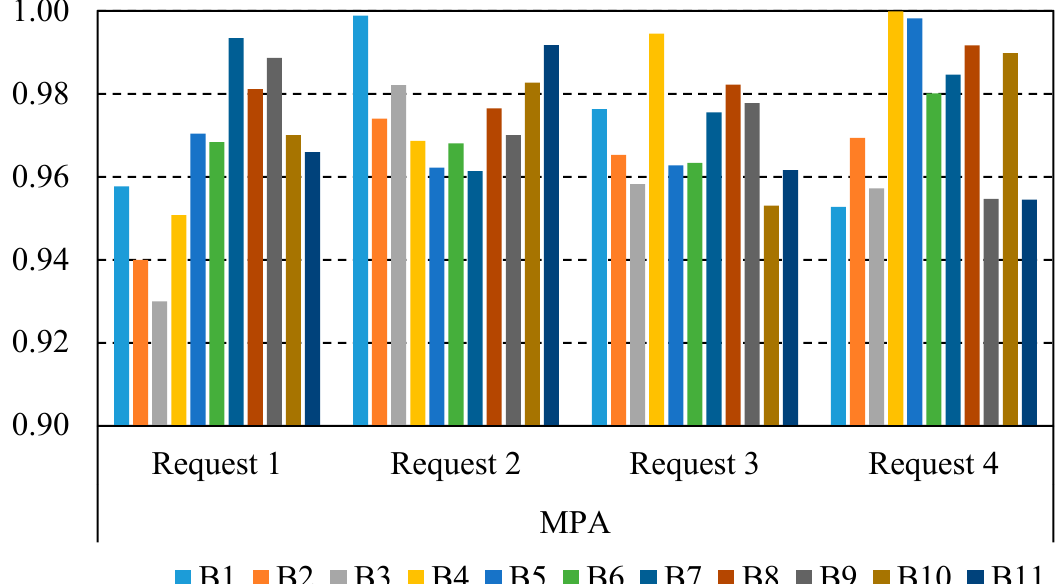
Figure 7. The MPA performance indicator in the East Aghili Canal.